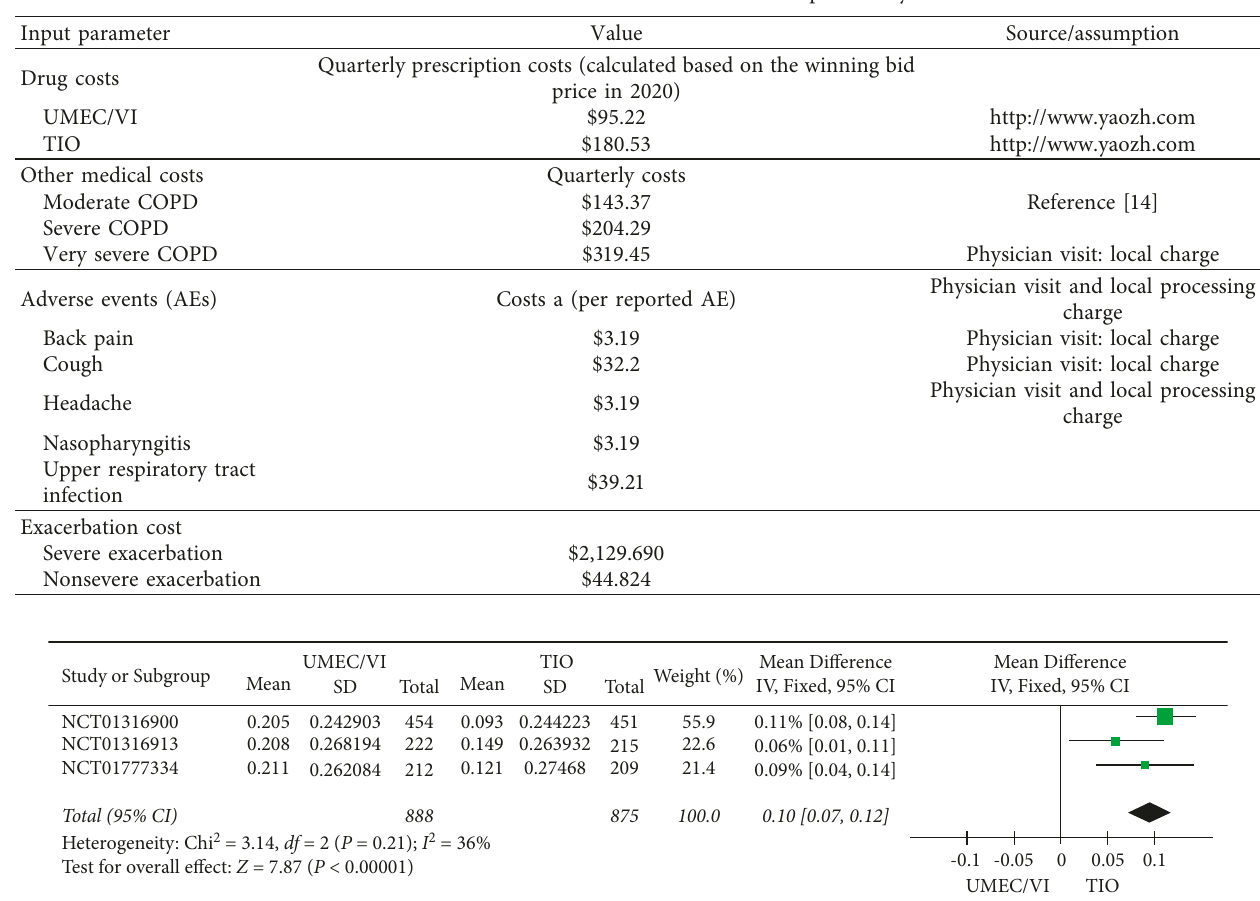
Table 4: Treatment-related costs of chronic obstructive pulmonary disease.